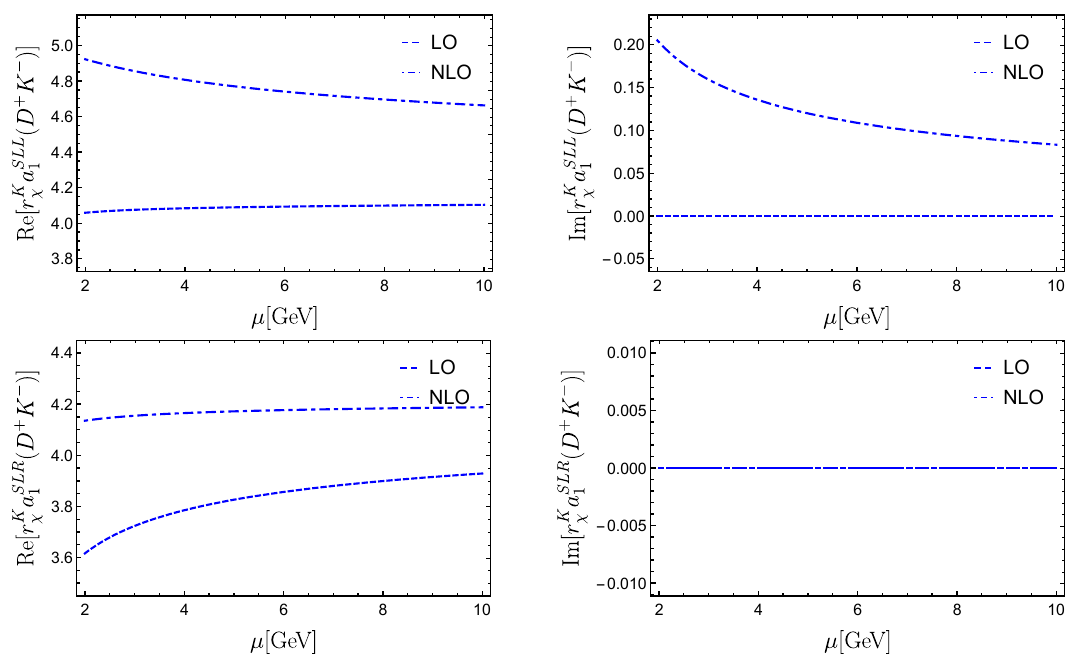
Figure 18 . Dependence of the effective coefficients r K renormalization scale µ . The other captions are the same as in figure